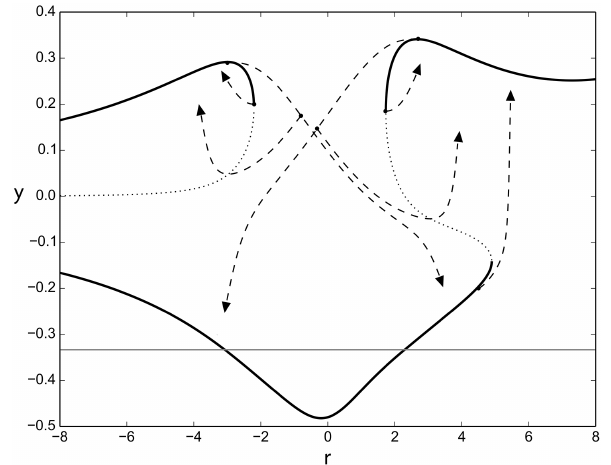
Figure 9. Bifurcations with manageable parameter. Loci of sta- ble (solid black lines) and unstable (dotted lines) fixed points of ˙ y =− (4 + r 2 ) 3 y 3 + (2 r 2 − 1)(4 + r 2 ) y + e r − 10. Leftmost and rightmost admissible management trajectories (dashed arrows) and their starting points (dots). Border (grey line) between sunny region y > − 1 / 3 and the dark. See Fig. 10 for an